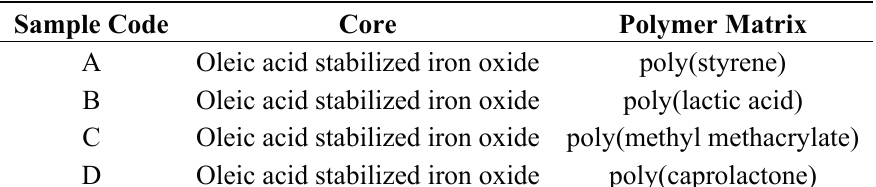
Table 1. Overview of produced multicore samples.